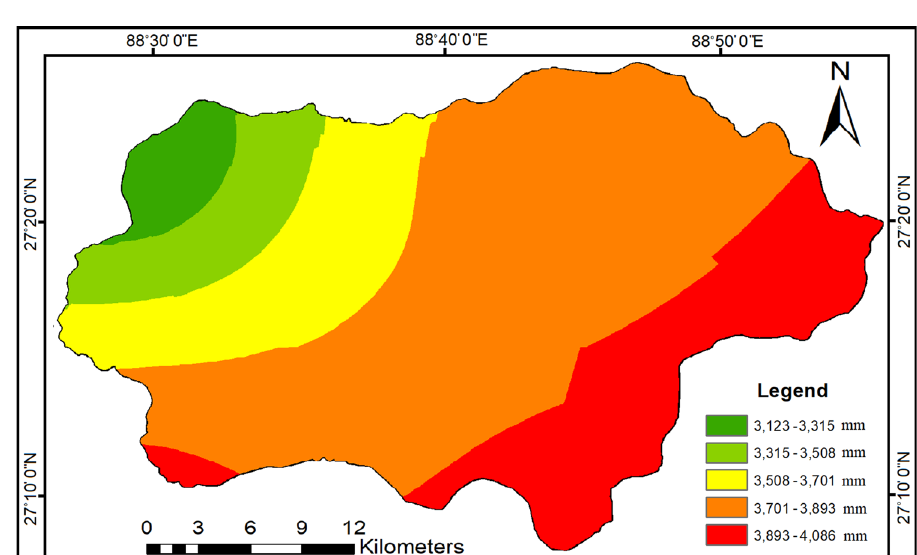
Fig. 11 Rainfall map of